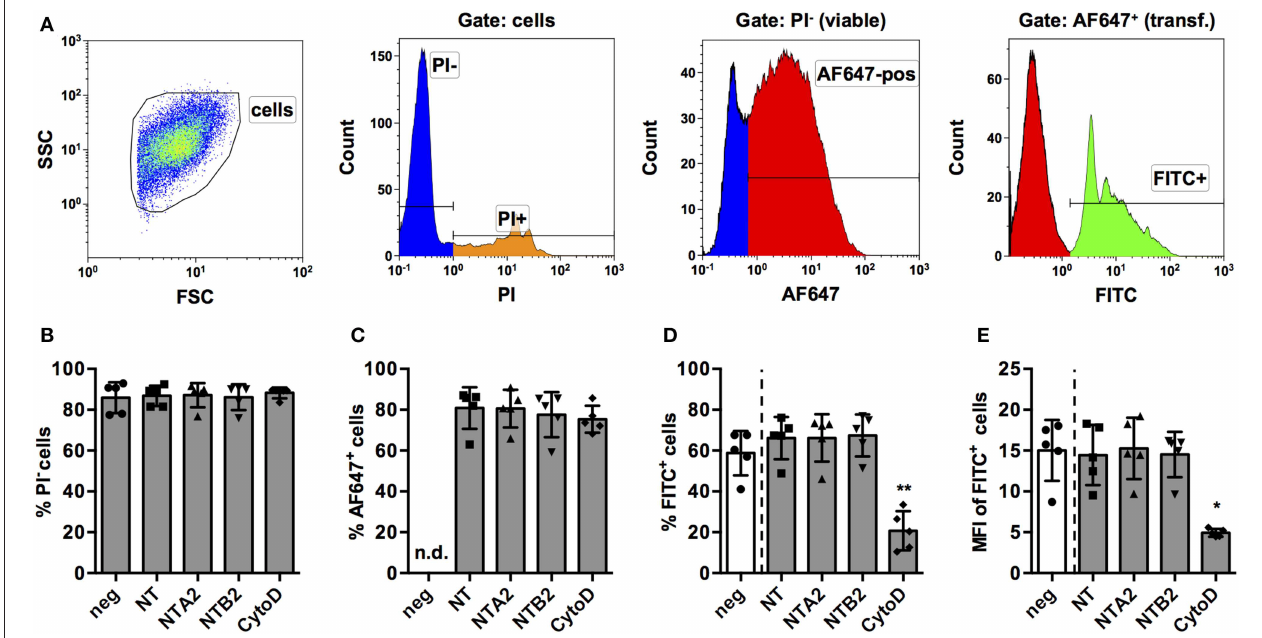
FIGURE 2 | Establishment of a FACS-based assay to screen for miRNAs for effect on phagocytosis of PMA-activated THP-1 M 8 . (A) Activated THP-1 Mq were identified by forward scatter (FSC) and side scatter (SSC), and viable cells were selected by excluding PI + cells. Viable cells were analyzed for successful transfection by positive AF647 staining of the control NT siRNA. Within the PI − AF647 + population, phagocytic cells were identified using the FITC signal of fluorescent latex beads. Viability of cells (% of PI − cells; B ), transfection efficiency (C) , percentage of phagocytic cells (D) , and phagocytic activity (MFI of FITC + cells; E ) were measured in cells transfected with the NT siRNA alone or in combination with two non-targeting miRNAs (NTA2 and NTB2) or with cytochalasin D treatment (CytoD). In (B–E) , individual values of n = 5 independent experiments are indicated by symbols and the mean ± SD are indicated by a bar and whiskers. Statistical analysis was performed using repeated measures, one-way ANOVA. Dunnett’s post analysis was used to calculate p -values adjusted for multiple comparisons with NT-transfected cells as control condition (* p < 0.05; ** p < 0.01). In (B) , negative control cells (neg) were set as control condition to check if any of the treatments had an effect on